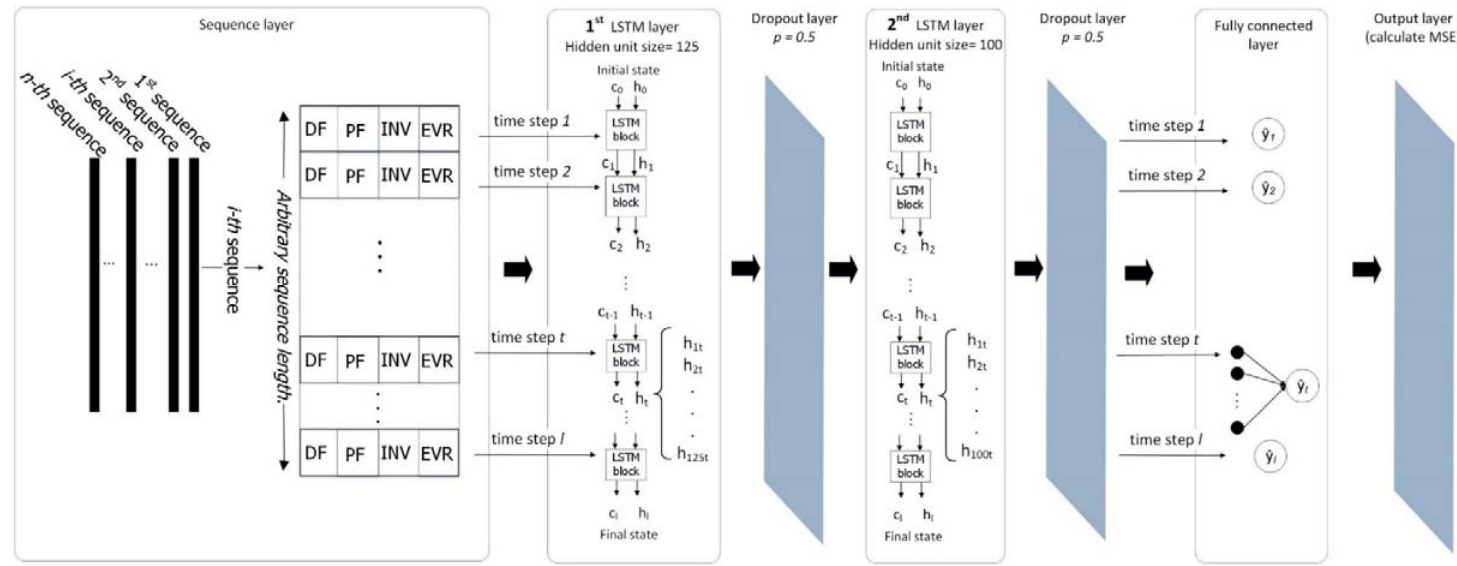
Figure 3. Designed long short-term memory (LSTM) structure. “n” shows the number of neurons in each LSTM layer and “p” shows the probability to exclude inputs from activation and weight updates to avoid overfitting. (MSE = mean squared error).